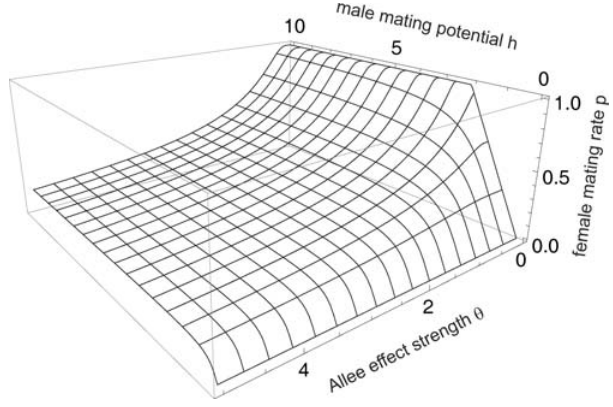
Figure 1. Shape of mating function (3). The mating function increases in h , decreases in h , and reduces to p ( m , f )=min( hm / f ,1) in the absence of the mate-finding Allee effect ( h =0). Male and female population sizes in the figure: m =1, f